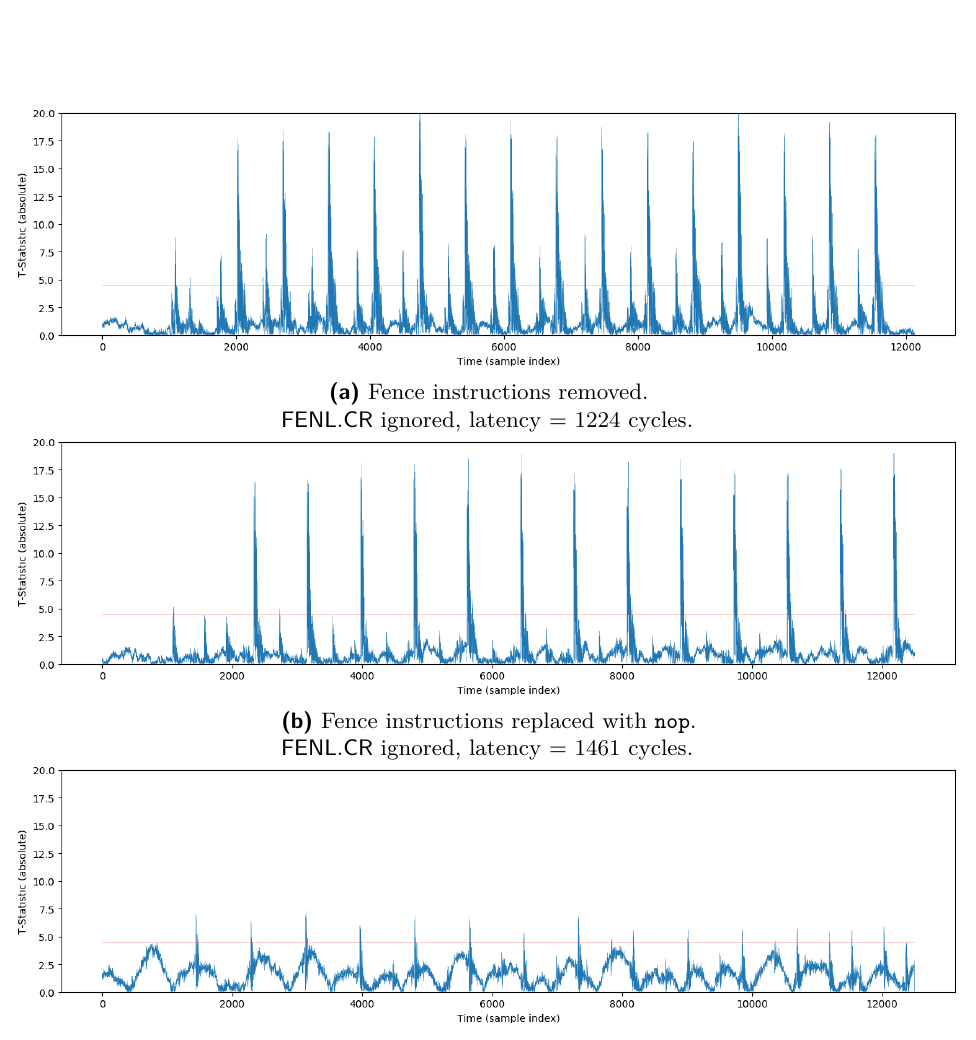
Figure 5: Results for experiment 1, relating to leakage from Figure 4 as executed on the PicoRV32 core (randomisation-based flush semantics). Note that the t-statistic is plotted in absolute form; the plots are cropped wrt. the target kernel, which has a longer latency post -insertion of fence